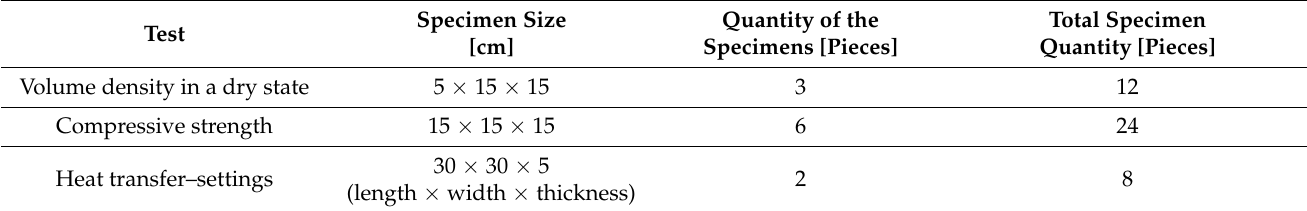
Table 5. The summary of the size and quantity of the specimens for testing.